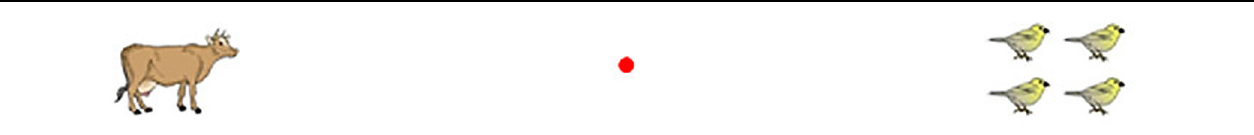
FIGURE 1 | Example visual display from a different-number